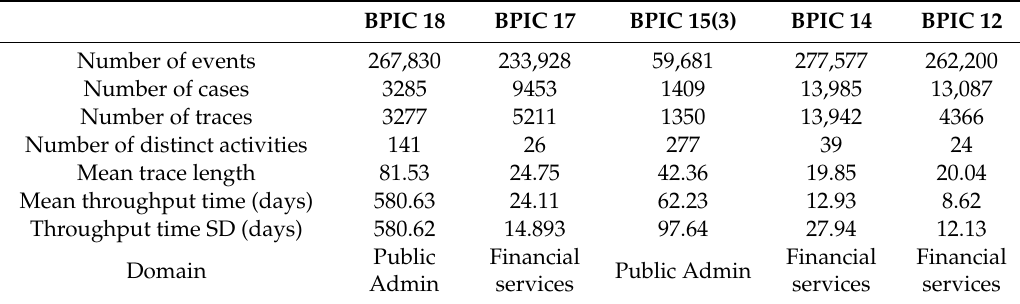
Table 1. Event Log